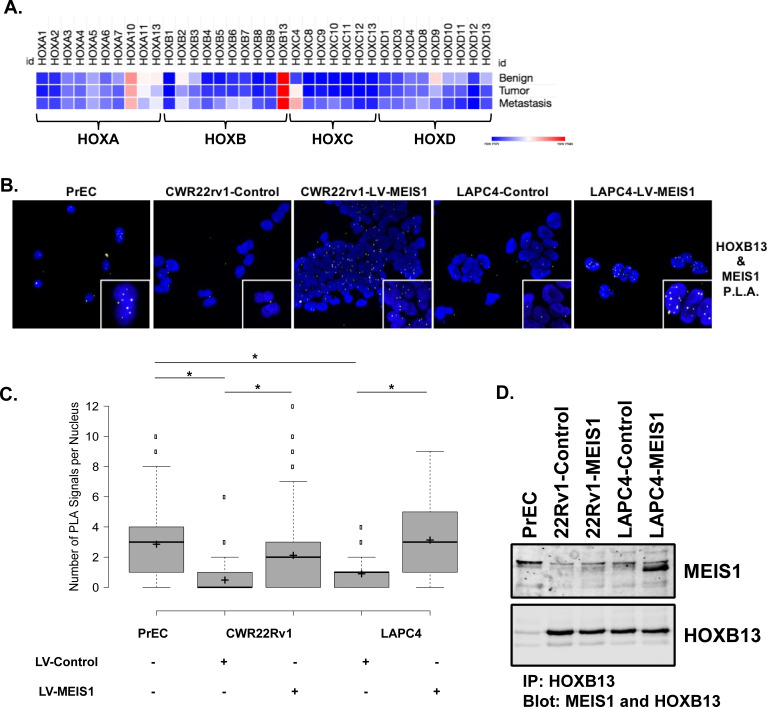
Exogenous MEIS1 expression rescues the nuclear MEIS1–HOXB13 interaction present in normal prostate epithelial cells.(A) Heatmap for HOX expression profile from publicly available, human RNA-seq data of benign prostate, primary prostate tumor, or metastasis from a prostate tumor. Log2(FPKM) values were used to generate heatmap. (B) In situ proximity ligation assay (PLA) to identify MEIS1/HOXB13 heterodimers in prostate epithelial cells (PrECs; short-term culture of primary epithelial cells from a de-identified patient, positive for expression of MEIS1 and HOXB13); CWR22Rv1-Control (expresses HOXB13 but has low to undetectable expression of MEIS1); CWR22Rv1-LV-MEIS1 (expresses HOXB13 and exogenous MEIS1); LAPC4-Control (expresses HOXB13 but has low expression of MEIS1); and LAPC4-LV-MEIS1 (expresses HOXB13 and exogenous MEIS1). Nuclei are stained with DAPI. Yellow puncta are the result of a positive PLA reaction and indicate MEIS1 and HOXB13 are within 40 nm of each other. Puncta were imaged as Texas-red fluorescence and pseudo-colored yellow for better contrast. Cells were imaged on the Keyence BZ-X800 microscope with 60x oil immersion objective. (C) Quantification of nuclear PLA signals in (B). Center lines show medians; box limits indicate 25th and 75th percentiles as determined by R software; whiskers extend 1.5-times the interquartile range from 25th and 75th percentiles, outliers are represented by dots; crosses represent sample means (n = 141, 422, 726, 107, 114, respectively). Boxplot generated with BoxplotR online tool (Spitzer et al., 2014) (*Welch’s t-test p<0.05). (D) Co-immunoprecipitation of MEIS1 with HOXB13 in PrECs and CWR22Rv1 and LAPC4 Control and LV-MEIS1 expressing cells.